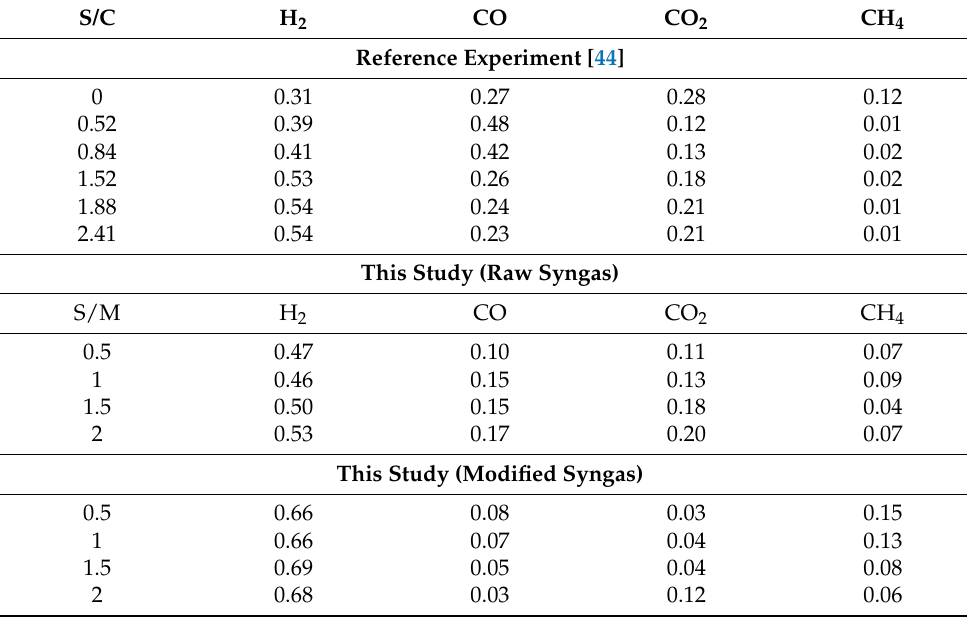
Figure 10. Effect of modification temperature on LHV and syngas yield for modified syngas. Table 5. Comparison for the effect of the steam amount.